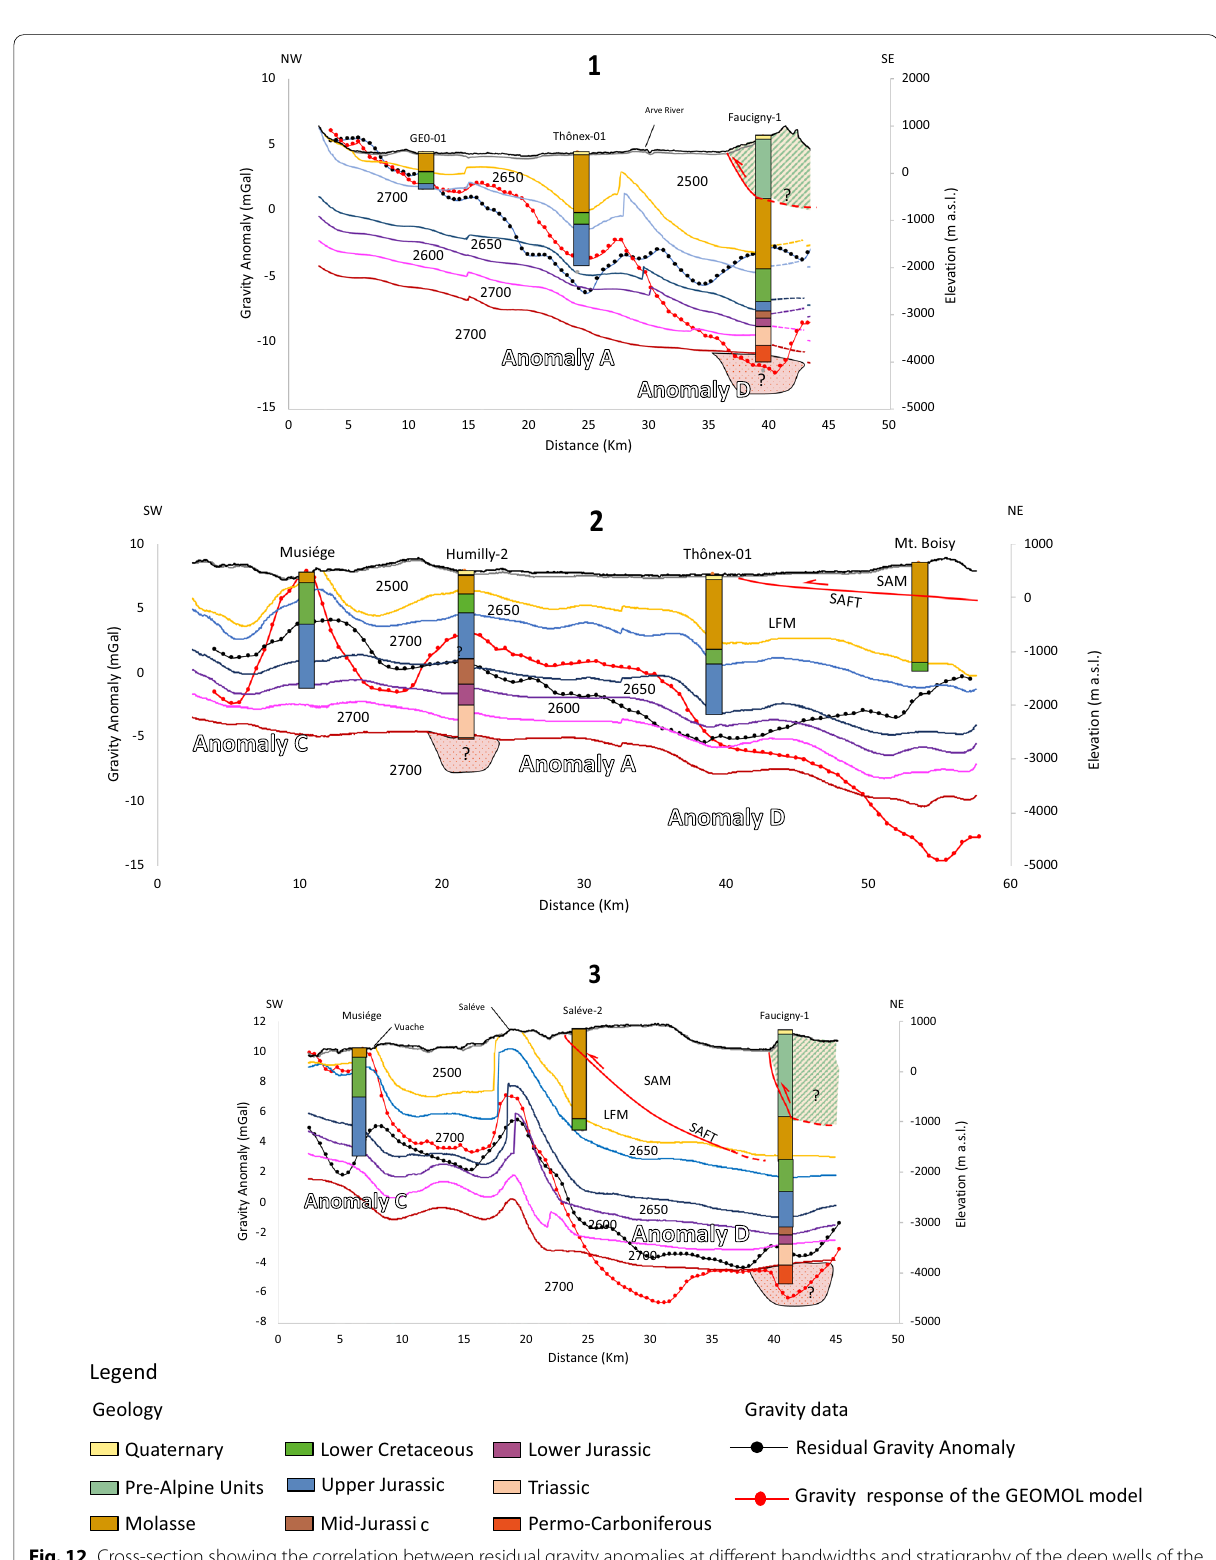
Fig. 12 Cross-section showing the correlation between residual gravity anomalies at different bandwidths and stratigraphy of the deep wells of the region (shown on the profiles). Density values (in kg/m 3 ) refer to data in Table